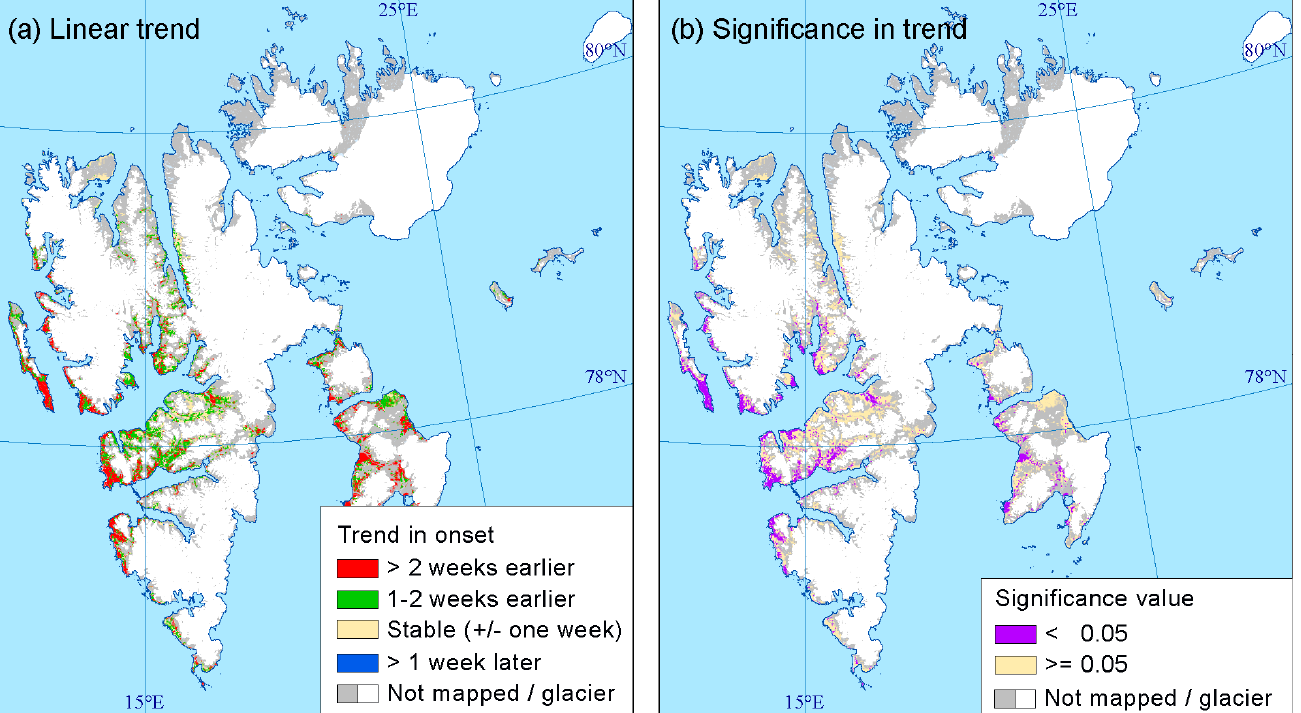
Figure 7. ( a ) Number of days of the earlier start of onset of vegetation growth in 2020, as compared to 2000, assuming a linear trend. ( b ) Areas where the linear trend is significant ( p < 0.05).